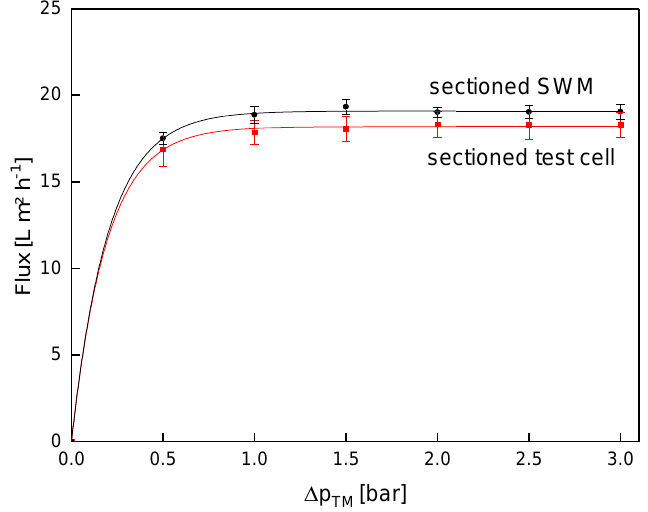
Figure 13. Comparison of flux obtained from the test cell (channel length of 1.00 m) and the sectioned SWM (length of 0.96 m) at a mean crossflow velocity of 0.42 m s − 1 .